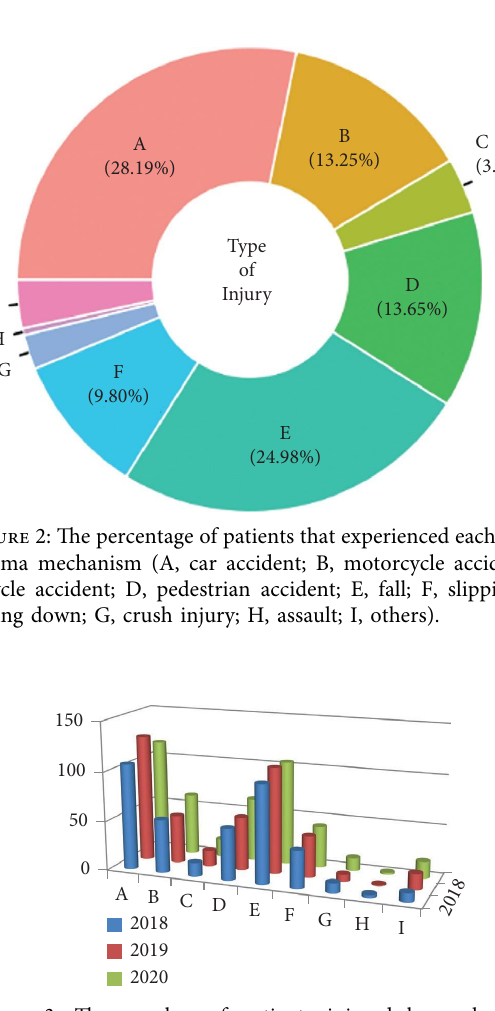
Figure 3: Te number of patients injured by each